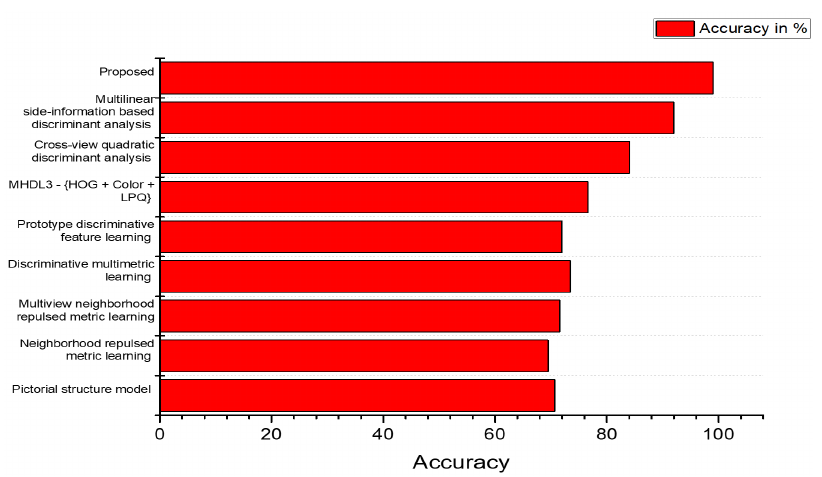
Figure 12. Comparison of accuracies achieved by JAFFE for different discriminant analysis methods.